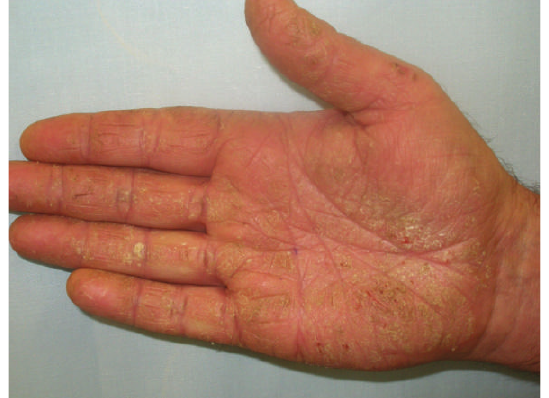
Figure 4: Tinea of the